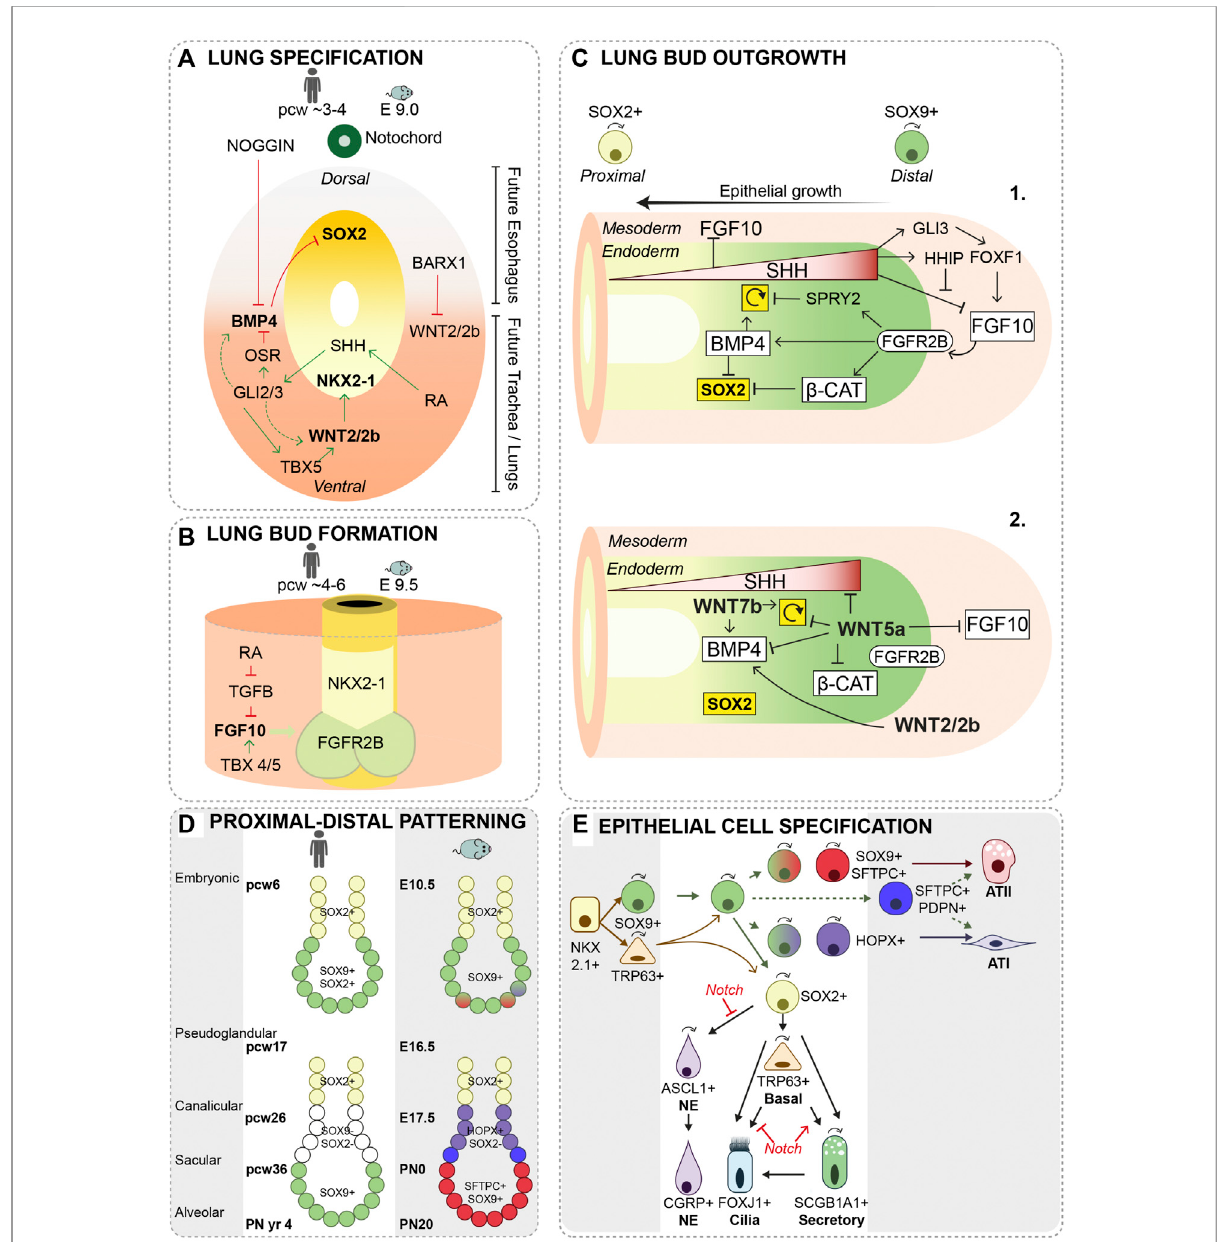
FIGURE 1 Lungspeci fi cation,primary lungbudformationandgrowth. (A) During lungspeci fi cation, Nkx2 - 1 expression isrestrictedto theventralsideand Sox2 to the dorsal side of the foregut endoderm. Retinoic acid (RA)-signaling activates RA receptors in the surrounding mesoderm driving cells to secrete Sonic Hedge Hog (SHH) in the ventral foregut mesoderm. SHH-responsive cells subsequently trigger activation of GLI2 and GLI3 transcription factors in the ventral mesoderm, which stimulate expression of WNT2/2b and BMP4 (Rankin et al., 2016). Odd-skipped related zinc fi nger transcriptional repressor, OSR, and SHH signaling target TBX5 are important modulators of WNT2/2b and BMP4 signaling (Han et al., 2017; Steimle et al., 2018). The transcription factor, BARX1, is expressed in the dorsal mesenchyme thereby repressing WNT signaling (Woo et al., 2011). (B) FGF10 from the ventral mesoderm is essential in lung bud formation, and is regulated by RA and TGF- β signaling. TBX transcription factors present in the foregut mesoderm has shown to be essential in regulating FGF10 expression as well (Sakiyama et al., 2003; Arora et al., 2012). E = embryonic day, pcw = post-conceptional week (C-1) Several reciprocal interactions between mesoderm and endoderm regulate the expansion ofthedistaltipthroughproliferation andsuppressionof Sox2 expression.SHHisexpressedinagradientwiththehighestexpressioninthedistalbud. SHH inhibits mesenchymal FGF10 expression just proximal of the distal bud. At high concentrations, SHH induces expression of, HH inhibitory protein(HHIP) inthedistal mesenchymeto allow for FGF10 expression via regulation ofGLI3 andFOXF1(Morrisey and Hogan, 2010).Proliferation of progenitor cells is positively regulated via BMP4 induction or inhibited via its antagonist SPRY2 (Weaver et al., 2000; Mailleux et al., 2001; Hyatt et al., 2004; Eblaghie et al., 2006). Sox2 expression is inhibited via Wnt- β -Catenin and BMP4 signaling (Volckaert et al., 2013; Wang et al., 2013). ↻ = proliferation. (C-2) Knock-out mouse models of WNT ligands demonstrated defects in lung development; WNT2/2b (canonical) (Hrycaj et al., 2015)